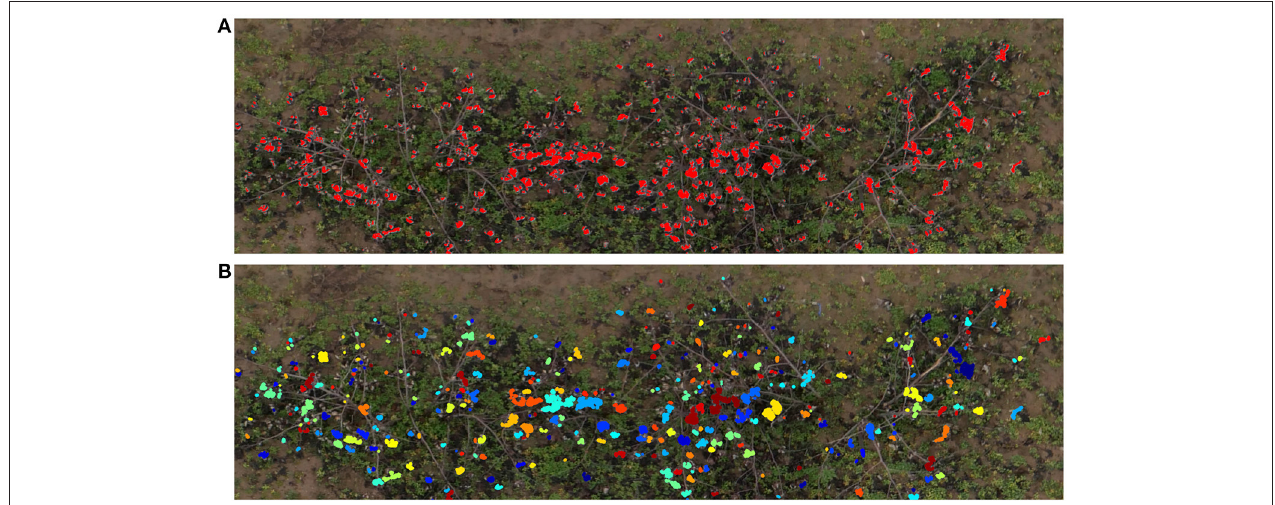
FIGURE 9 | Cotton boll inference results. Cotton pixels segmentation and clustering results for a representative plot (Plot ID 45003), (A) SVM classifier inference results. Red pixels represent the cotton pixels detected by the SVM classifier as cotton, (B) Cotton boll clustering results. Each cluster is identified by a unique color.